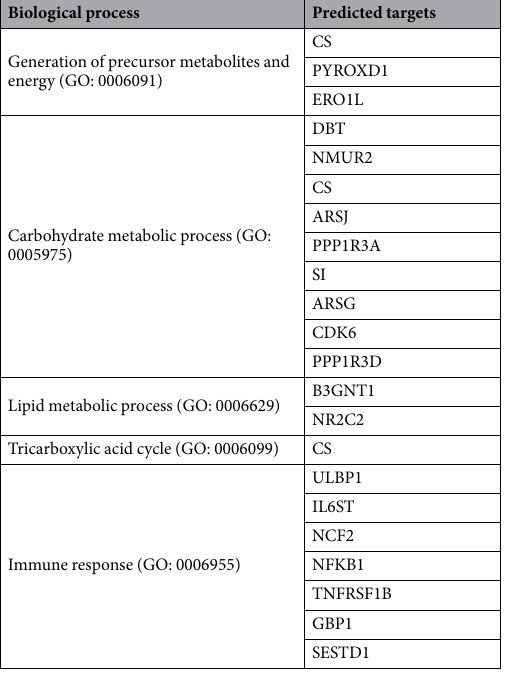
Table 4. The predicted targets of miR-532 and the involved biological processes analyzed by Gene